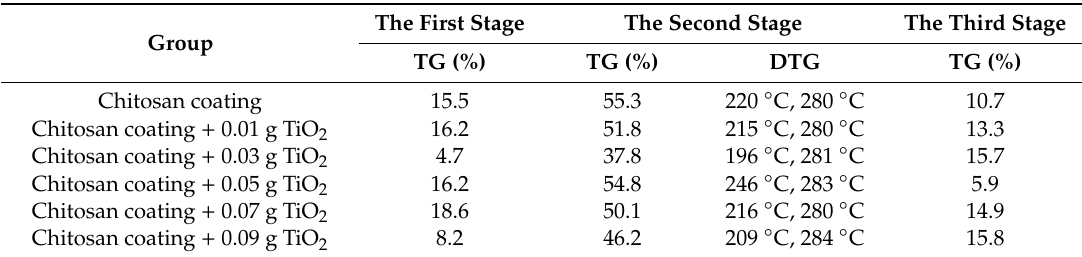
Table 2. Values of thermogravimetric (TG) analysis after the treatment by the chitosan-based coating film with TiO 2